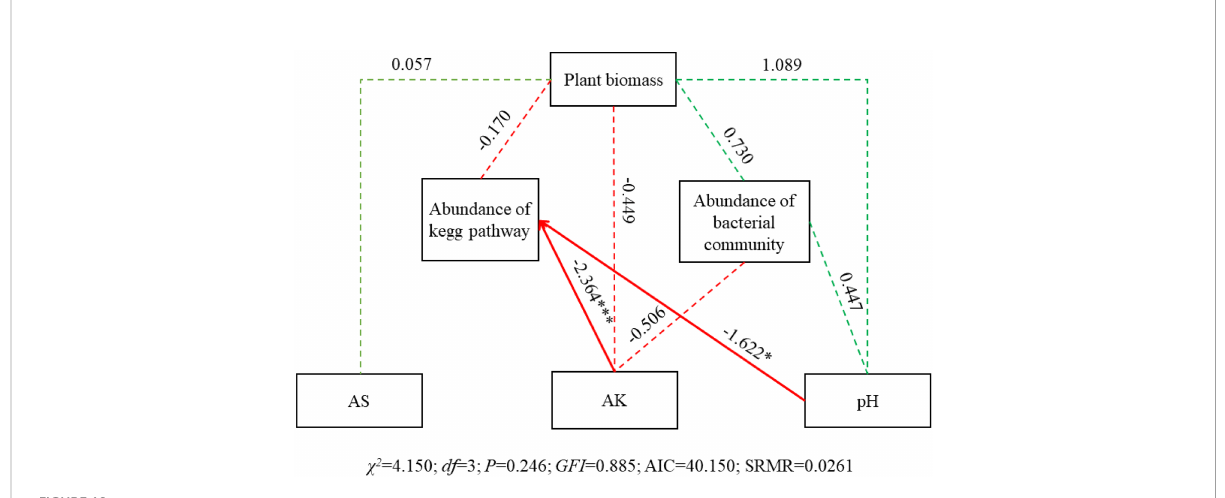
FIGURE 10 SEM of the effects of soil physicochemical characteristics, bacterial community and KEGG pathways on plant biomass. Square boxes denote variables included in the models. Values associated with solid arrows represent standardized path coef fi cients (SPCs) and asterisks mark their signi fi cance: * P < 0.05; *** P < 0.001. Solid arrows denote the directions and effects that were signi fi cant ( P < 0.05). Dashed arrows represent the directions and effects that were non-signi fi cant ( P < 0.05). Green arrows indicate a positive relationship ( P < 0.05), while red indicates a negative correlation. CFI = 0.885 is result from the chi-squared value is less than the degrees offreedom in this SEM. Abundance of bacterial community, PCA1 of the abundance of the top 100 OTUs; Abundance of the abundance of the top 100 pathways; AK, available potassium; AS, available